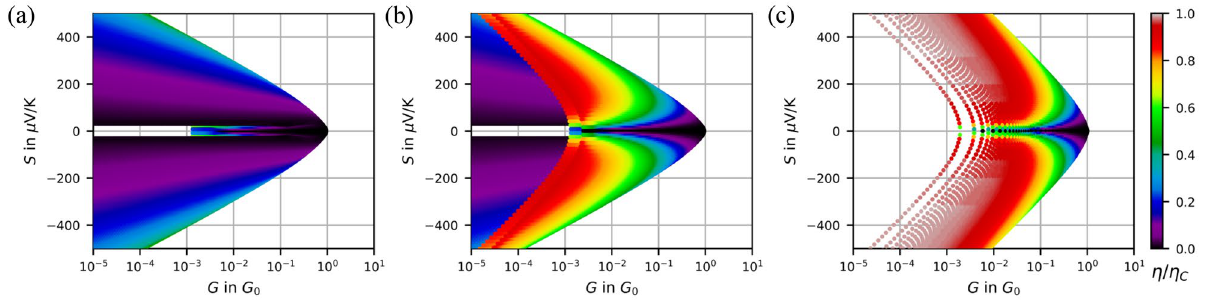
Figure 4. Heat conversion efficiency η of the electronic system calculated with respect to Carnot-efficiency η C . ( a , b ) are calculated within the resonant level model. In ( a ) the off-resonant regime is in the foreground whereas in ( b ) the near-resonant regime is visible. ( c ) rectangular transmission function for comparison. Note that here also the excluded area